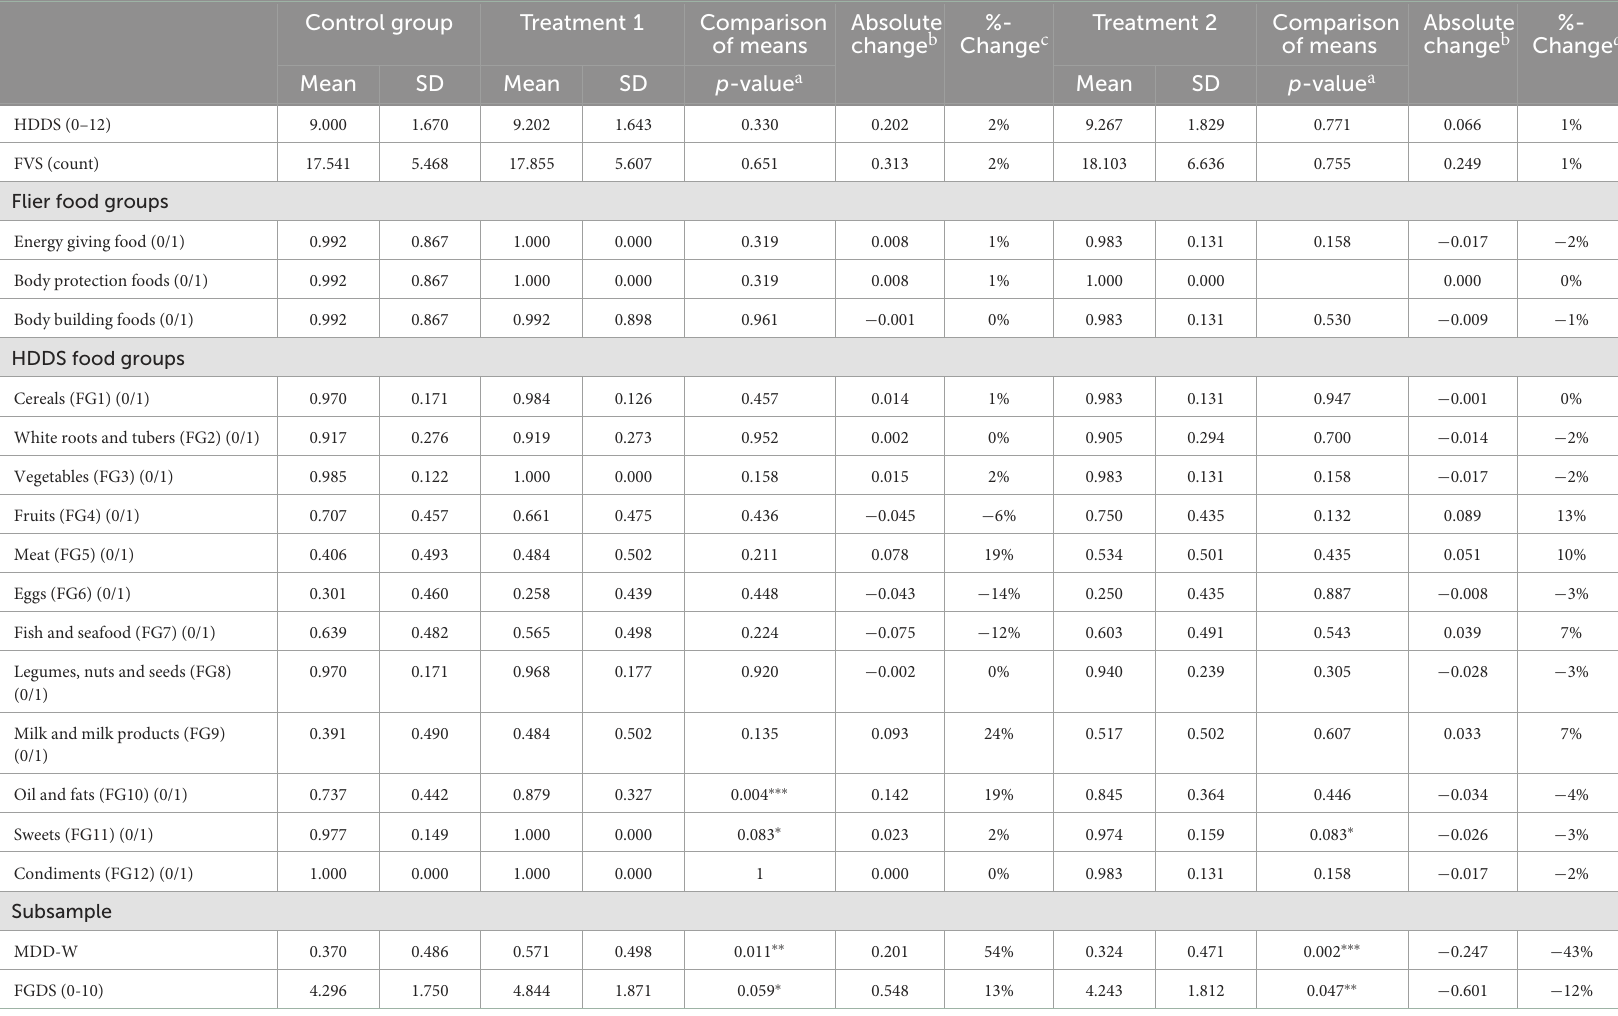
TABLE 5 Descriptives statistics of nutritional indicators by treatment groups in December 2021 (post